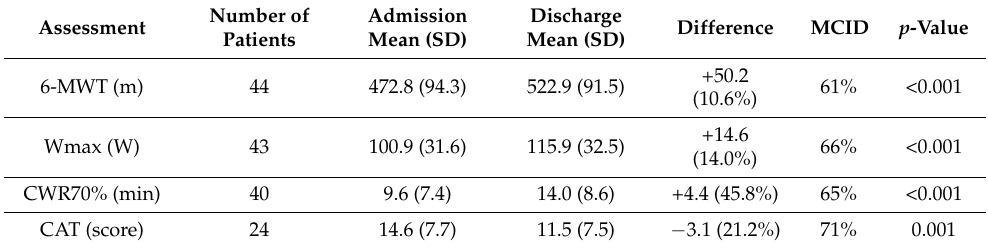
Table 2. Exercise assessment and CAT at admission and discharge of outpatient pulmonary rehabilitation.